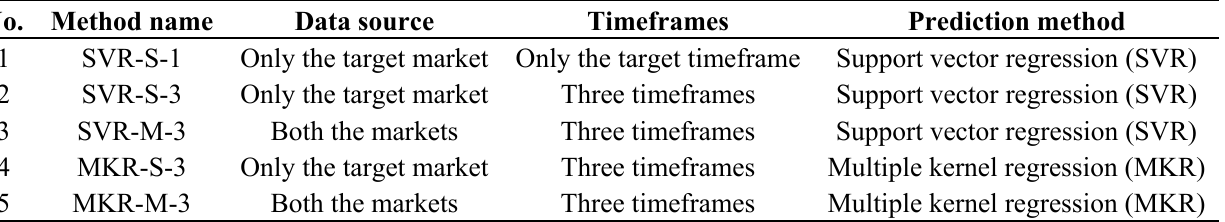
Table 2. A list of proposed and benchmark